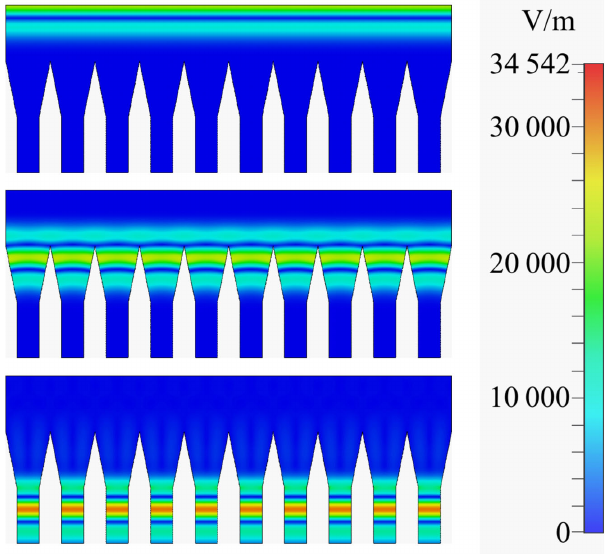
FIG. 10. Time snapshots of thereflection from the structure/ vacuum